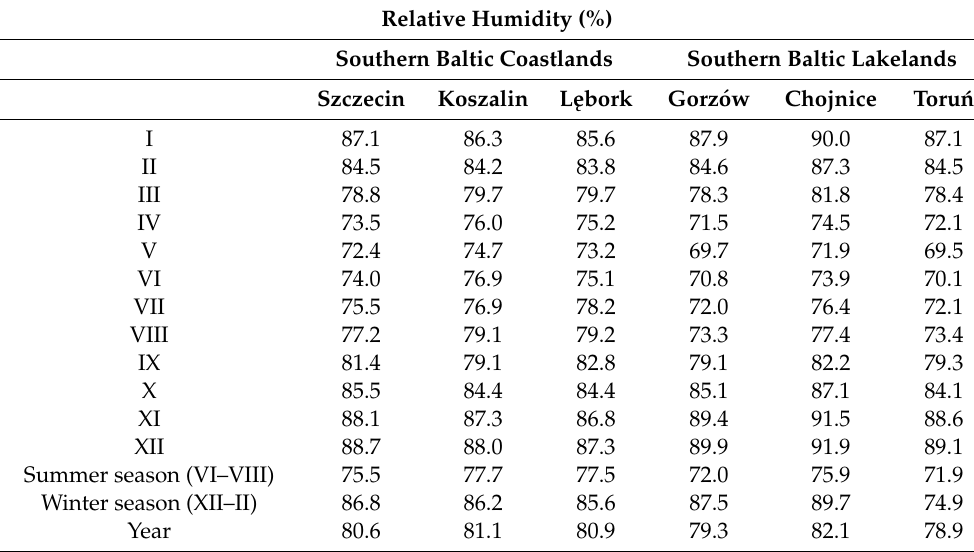
Table 3. Average monthly, semi-annual and annual values of relative humidity (%) in the studied stations, 1952–2018 (calculated based on data obtained from the Polish Institute of Meteorology and Water Management—National Research Institute